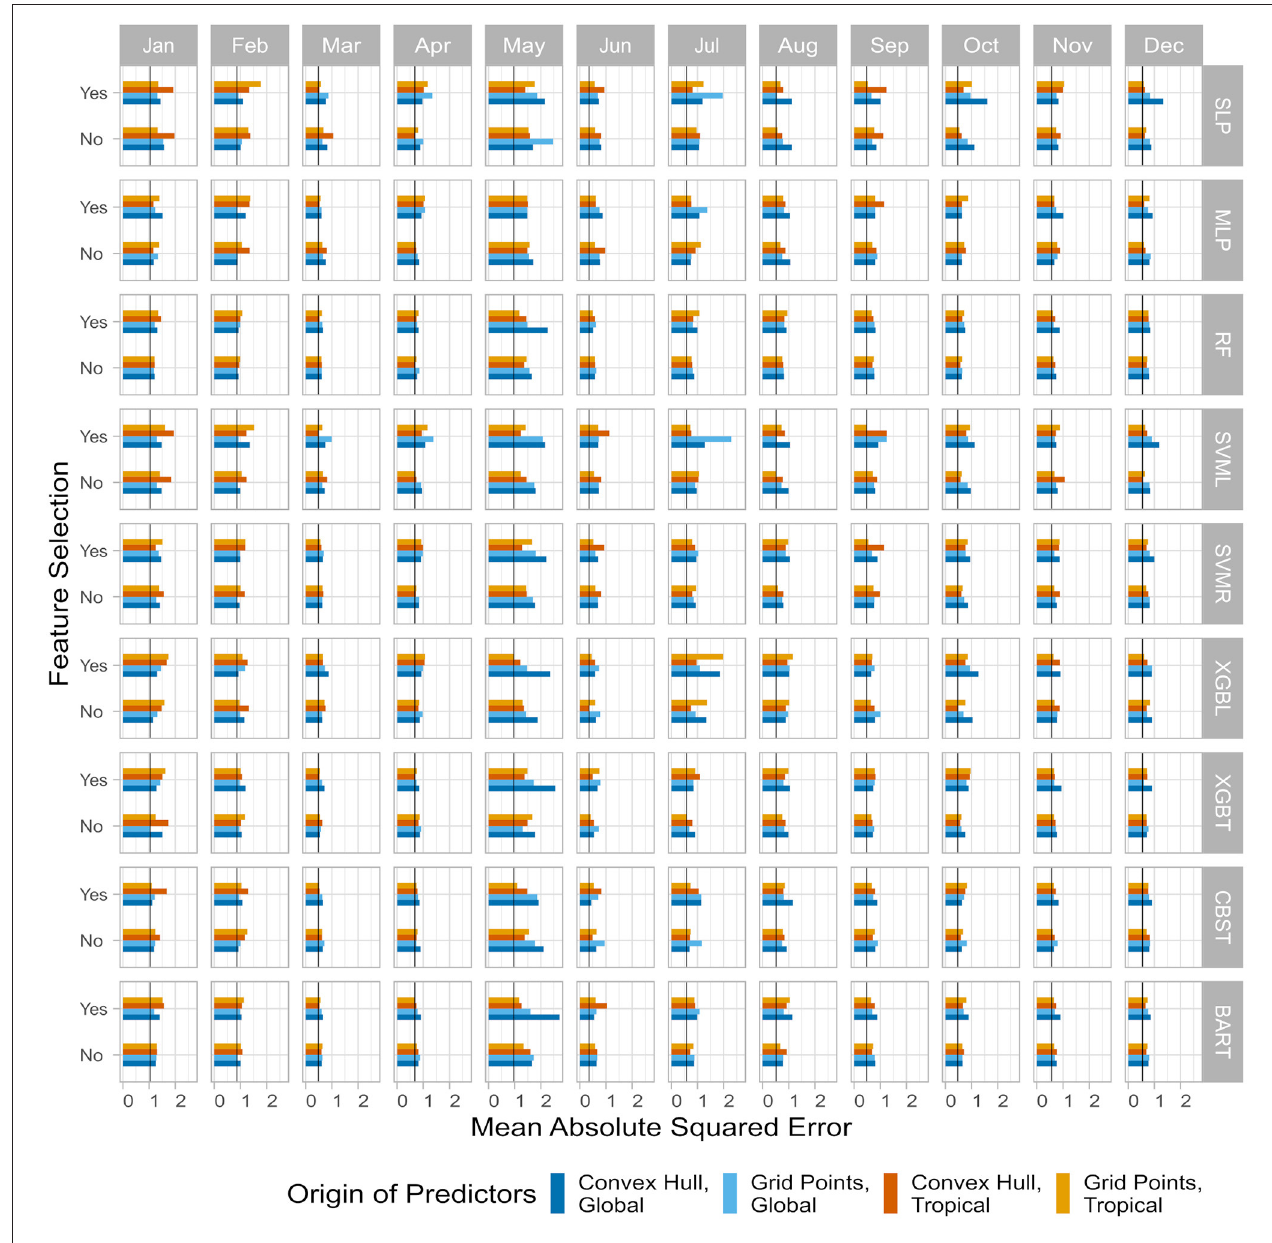
FIGURE 7 | Same as Figure 5 but for the mean absolute scaled error